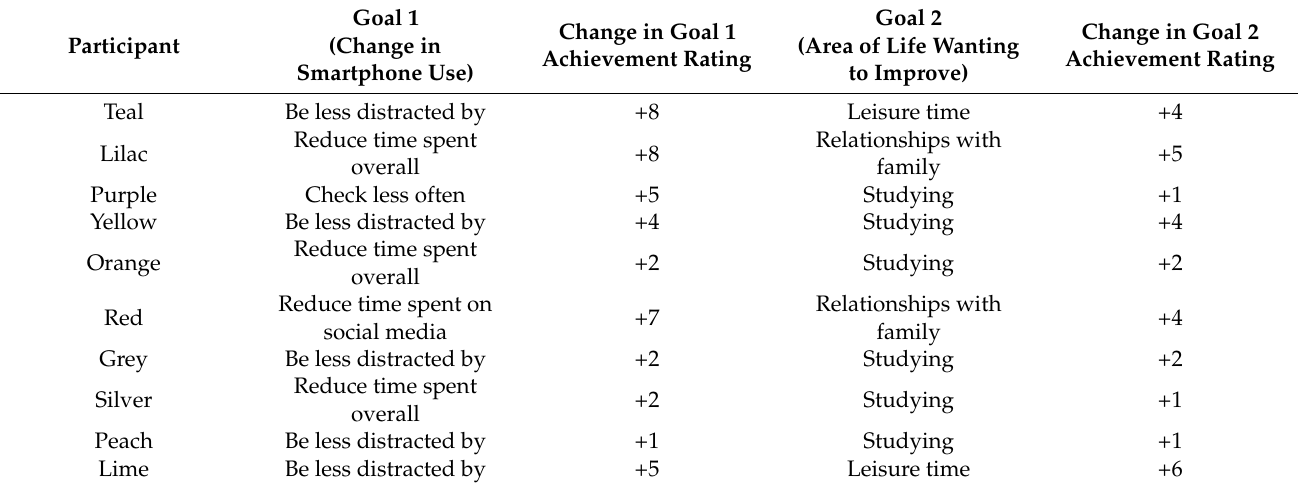
Table 4. Changes in goal-based